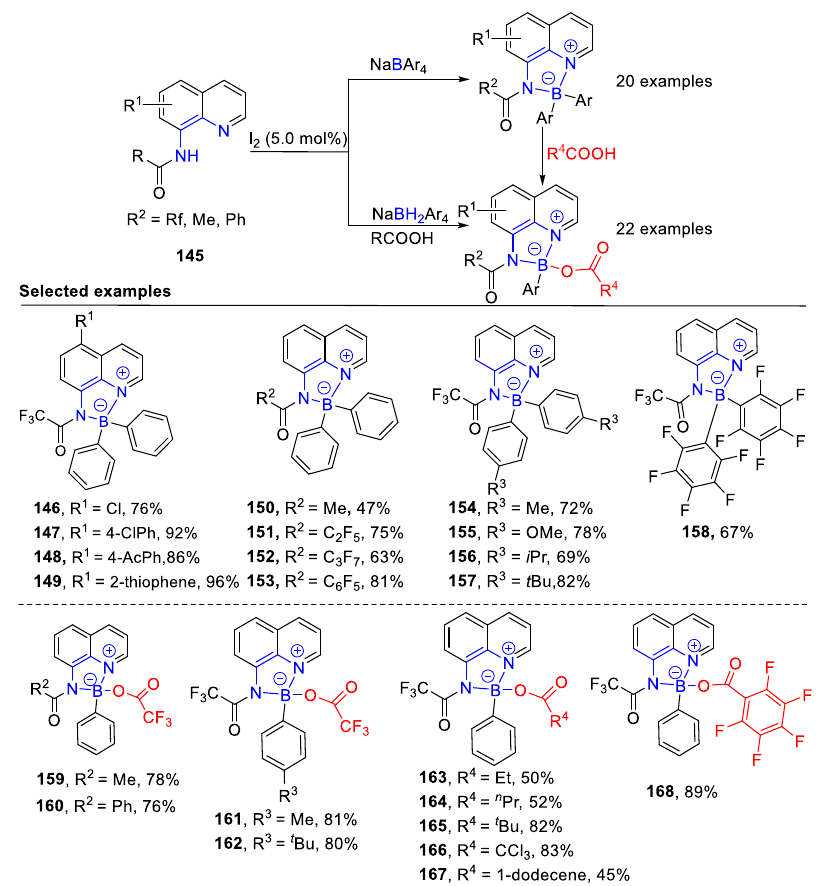
Scheme 27. Synthesis of 3-phenyl- N -(quinolin-8-yl)propanamide derivatives chelate organoboron photocatalysts